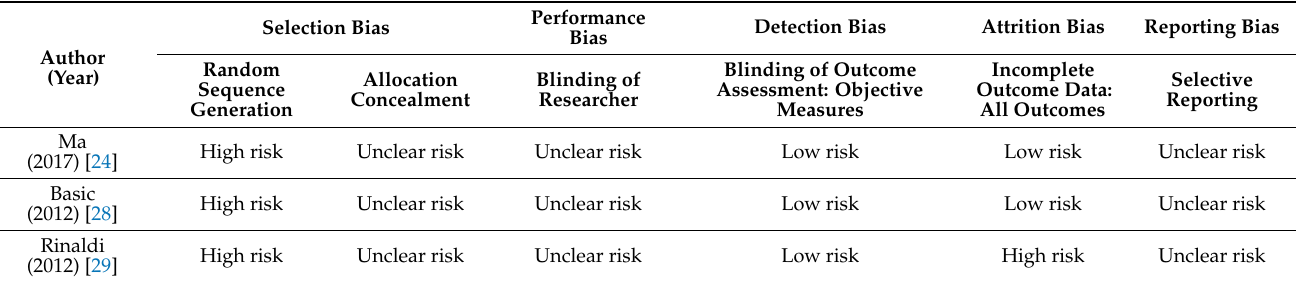
Table 3. Risk of bias in the included